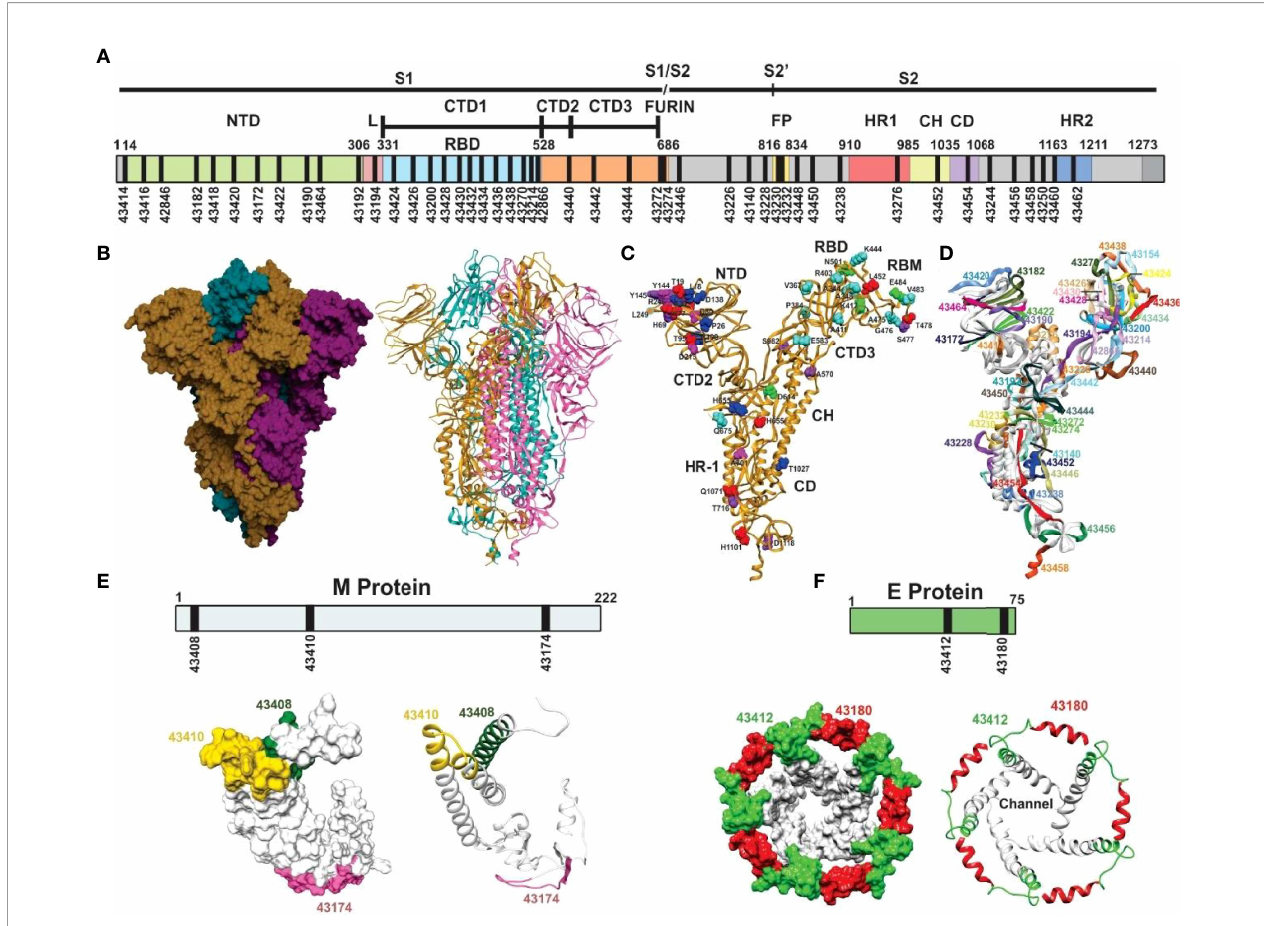
FIGURE 2 | Schematic representation of SARS-CoV-2 S protein. (A) Schematic representation of the SARS-CoV-2 S protein. The S1 subunit containing the N-terminal domain (NTD), connecting loops in C-terminal domains CTD1, 2, and 3, mediating hinge up or down CTD1 rotation, exposing the receptor site for interaction with the ACE2 protein, the cell tropism-mediating, host range, and transmission receptor binding domain (RBD) and the S1/S2 furin site for S cleavage into S1 and S2 subunits. The S2 subunit contains the fusion peptide (FP) hydrophobic fusion-peptide proximal region (FPPR), the heptad-repeat regions (HR1 and HR2) with their connecting domains (CD) enabling six helix bundle fusion core conformation to mediate host cell invasion. (B) Trimer S protein Cryo-EM structure [surface and ribbon representation (33, 34), each protomer shown by a different colour]. (C) S protein protomer ribbon diagram showing VOC mutant residue locations: alpha (green), beta (fuchsia), gamma (dark blue), delta (red), and common (orange) and VOIs in aquamarine (epsilon, eta, and iota). (D) S protein protomer backbone structure (ribbon), showing the location of selected peptides to be modi fi ed for SM - COLSARSPROT, numbered according our Institute ’ s serial numbers ( Figures 5 , 6 ). (E) Predicted M protein structure (36) (surface and ribbon) with selected regions (numbers are our serial numbers). (F) 1 H-NMR determined SARS-E protein structure (35) (surface and ribbon) with selected regions (numbers are our serial numbers), showing the ion